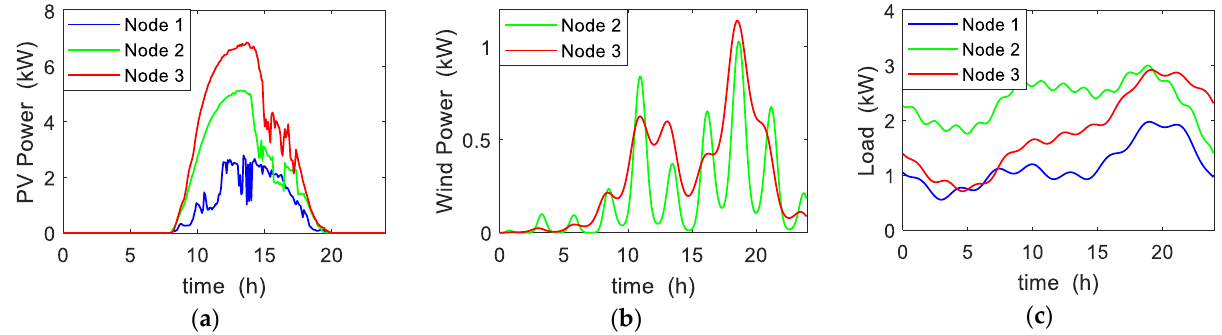
Figure 3. Renewable power and loads in daily operation: ( a ) PV power production; ( b ) Wind Turbine power production; ( c ) Local load demand.